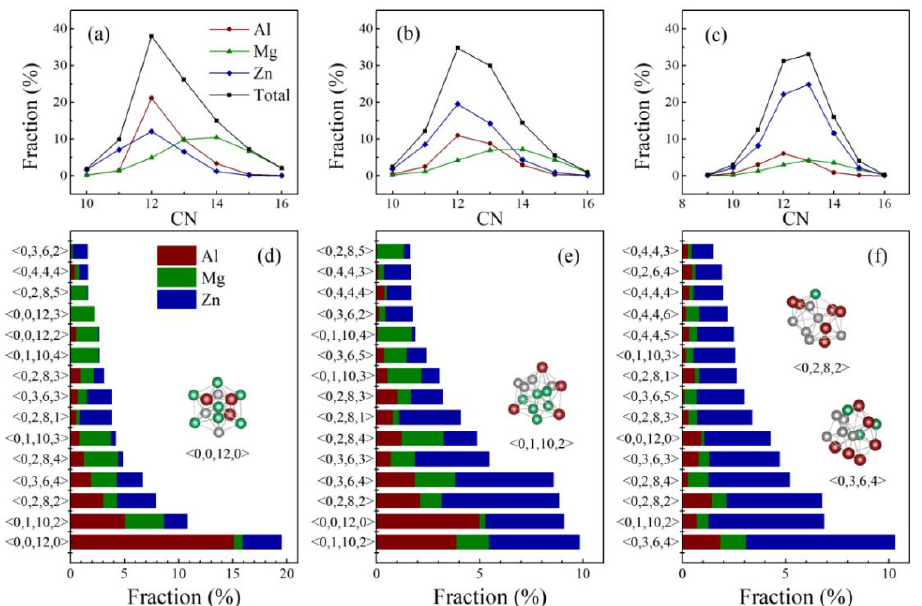
Figure 5. The partial and total CNs distribution of the MD-derived metallic glasses: ( a ) Al 35 Mg 35 Zn 30 , ( b ) Al 25 Mg 25 Zn 50 , ( c ) Al 15 Mg 15 Zn 70 . The spectrum of the most frequent Voronoi clusters in the MD- derived metallic glasses: ( d ) Al 35 Mg 35 Zn 30 , ( e ) Al 25 Mg 25 Zn 50 , ( f ) Al 15 Mg 15 Zn 70 .